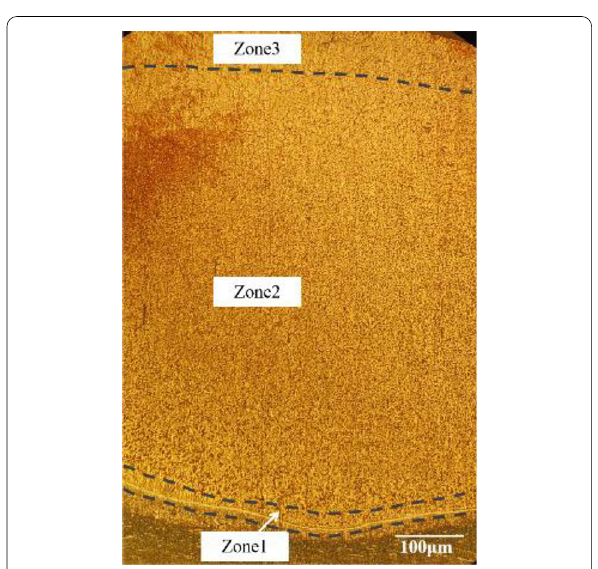
Figure 6 OM images of a metallographic specimen of the laser